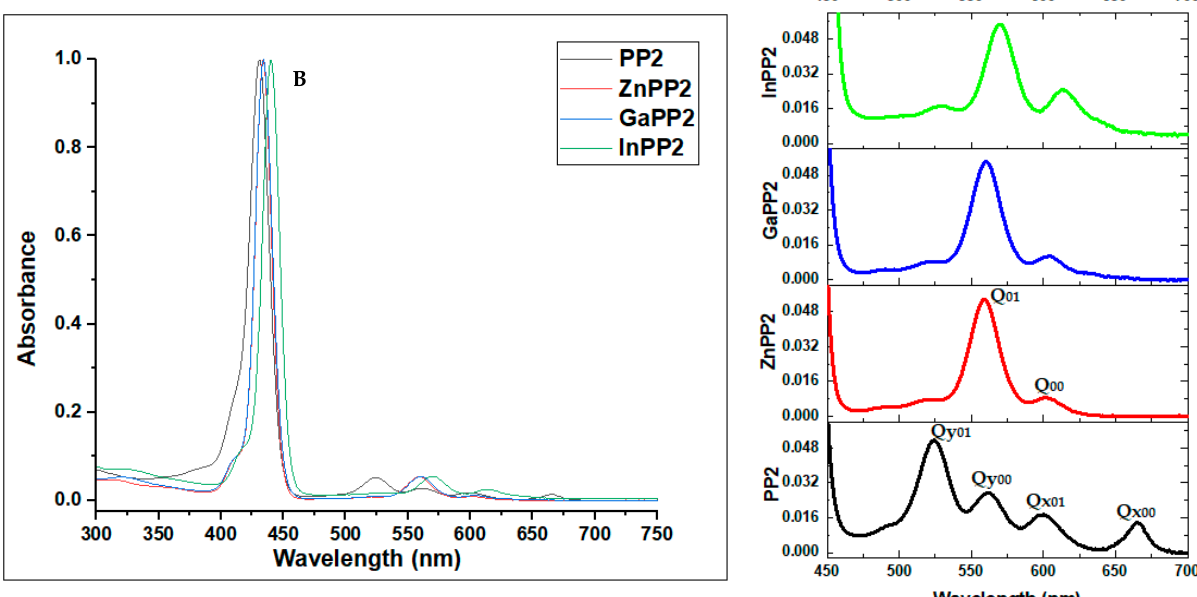
Figure 2. ( Left ) Normalized absorption spectra of PP2 and the corresponding metal complexes in toluene. ( Right ) Spectra zoom in the Q band region.